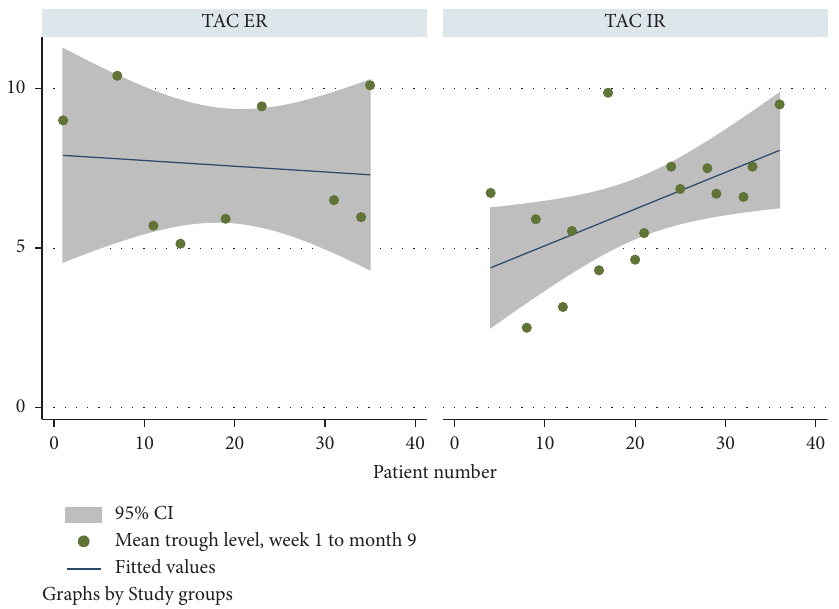
Figure 1: Mean PROMIS-29 scores, week 4-month